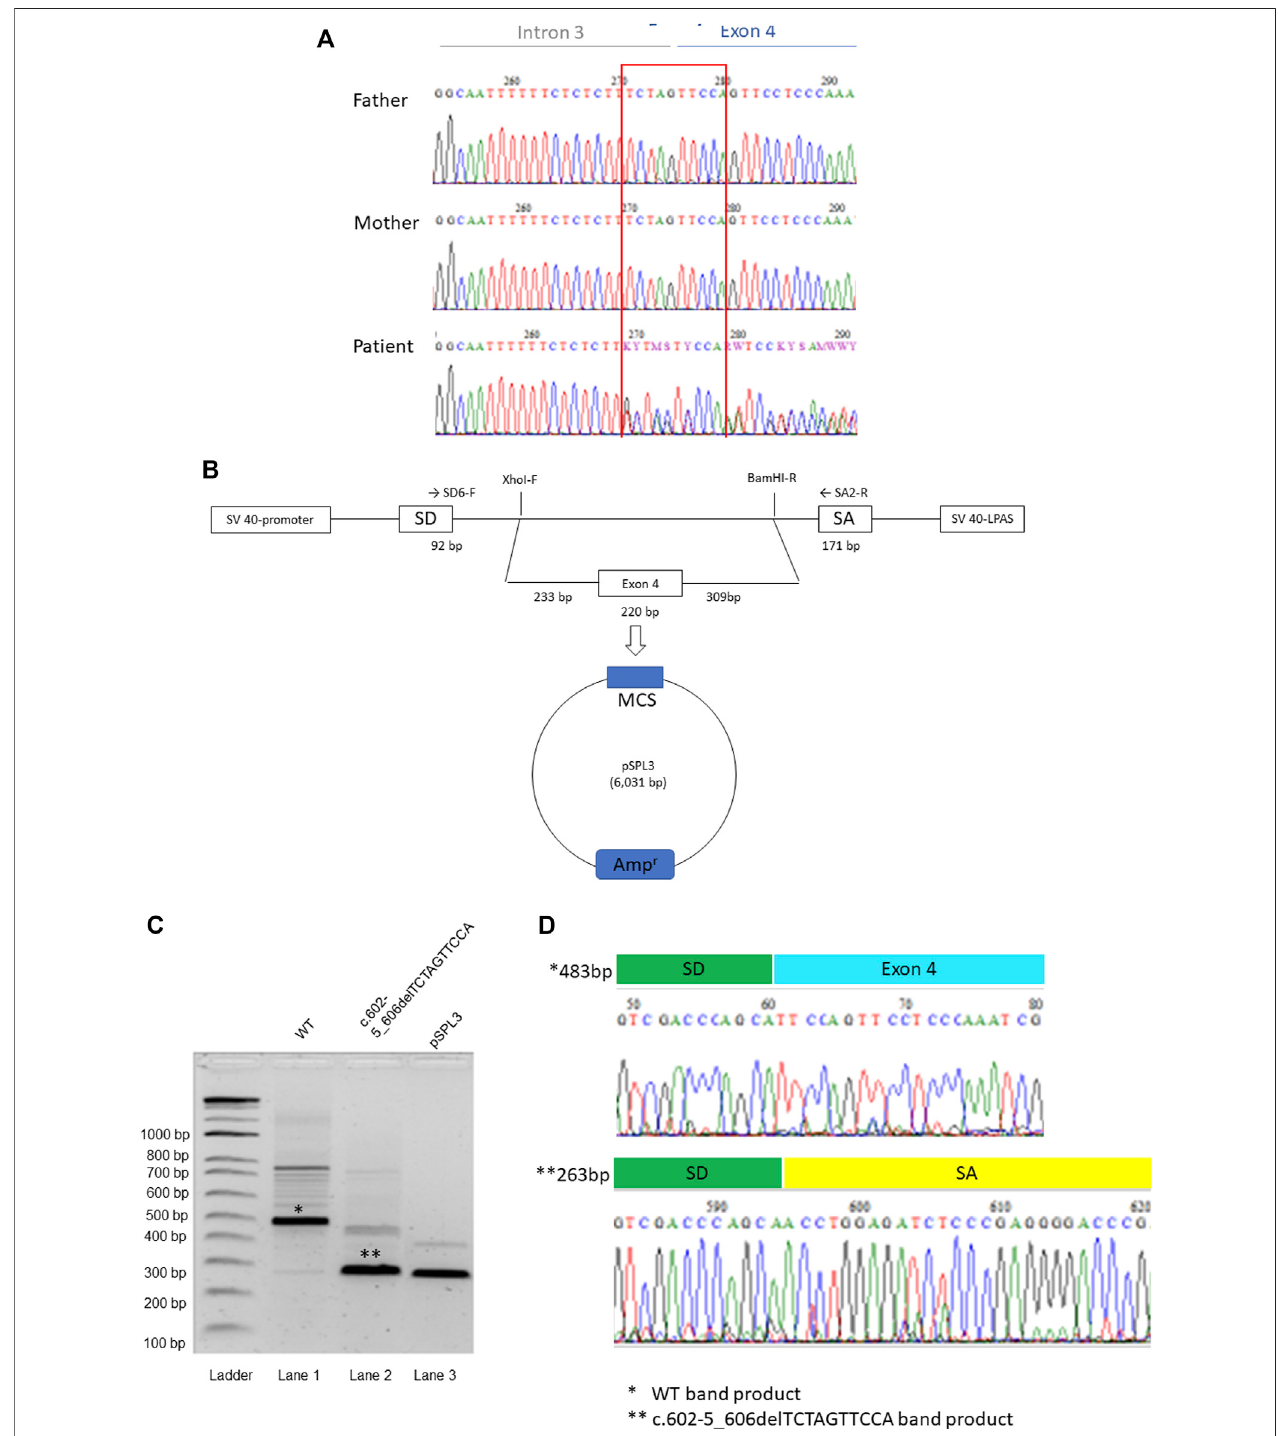
FIGURE 1 | using Fiji ImageJ software. The proportion of differentiated enteric neurons was determined by calculating the ratio of HuC/HuD + cells to phox2bb:GFP + cells. All larvae were genotyped at the end of the experiment.